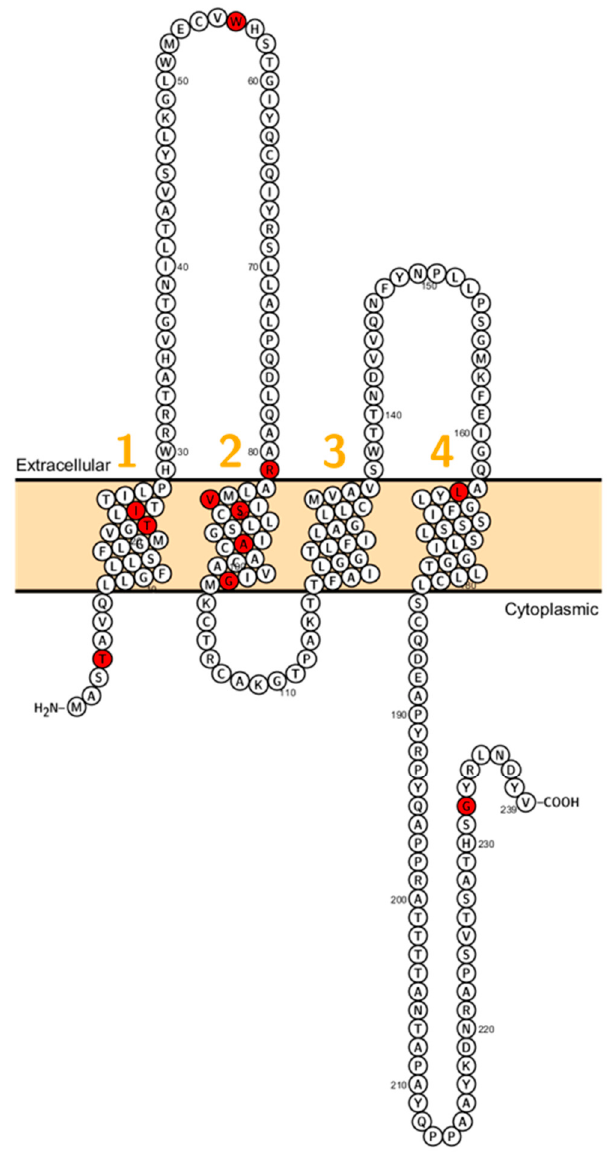
Figure 5. Topology of CLDN14 . FASTA sequence of CLDN14 (Uniprot accession no: O95500). Each amino acid is shown as a single letter code and numbers (orange) indicate transmembrane domains. Mutations shown to be involved in human diseases are shown in red.